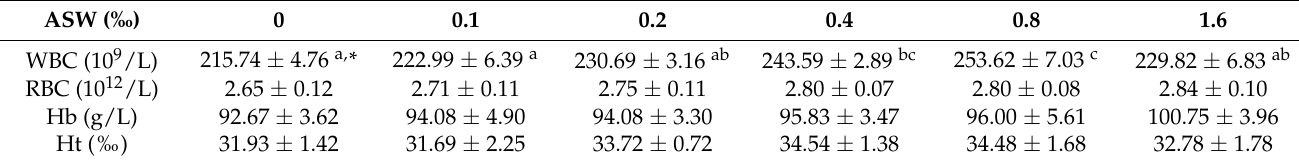
Table 4. Effect of ASW on blood parameters of GIFT (mean ± SEM).